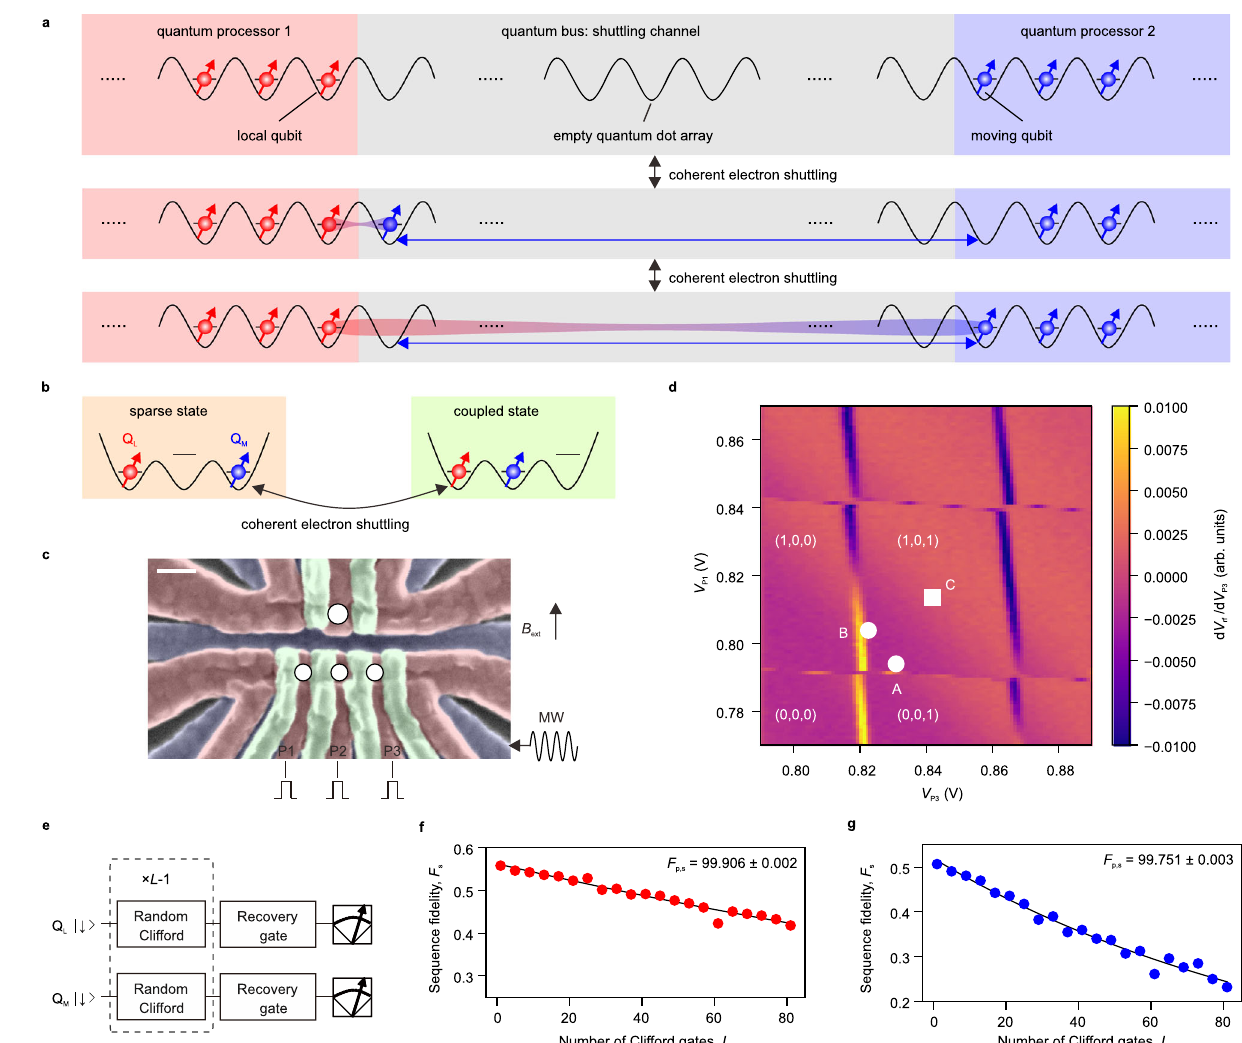
Fig. 1 | Concept of experiment and qubit characterization. a Concept of the experiment showing howatwo-qubit gate between spinqubits atdistant quantum processors is implemented to control entanglement between the qubits, making a quantum link betweenthe quantum processors. The two-qubitgate isexecutedby coherentshuttlingofthemovingqubittocontroltheexchangecoupling.Anempty quantum dot array isused asashuttling channelwhichworksasaquantum bus. In the experiment, we use a tunnel coupled triple quantum dot containing two spin qubits in two quantum processors and a shuttling channel consisting of a single quantumdotasshownin b . b Twooperationstatesusedinthiswork.Thelocaland movingqubitsarelocatedapartintheendquantumdots(sparsestate)andtheyare coupled when the two qubits are located in the nearest-neighbor quantum dots (coupled state). c False color scanning electron microscope image of a device nominally identical to the one used in this work 1 . The white circles show the